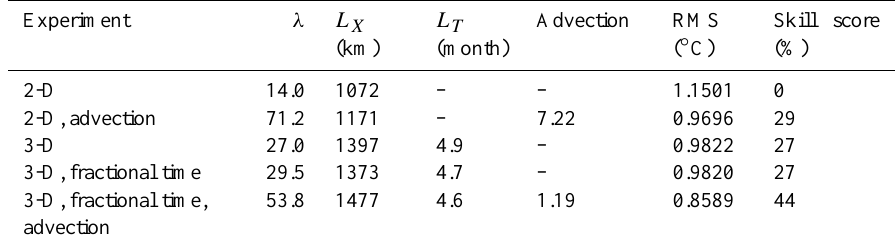
Table 6. Summary of all experiments with the optimal parameter values.